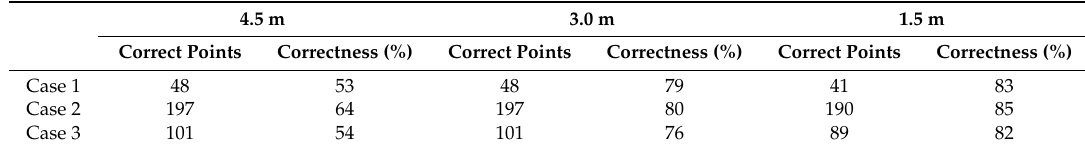
Table 2. The analysis of threshold T 1 .